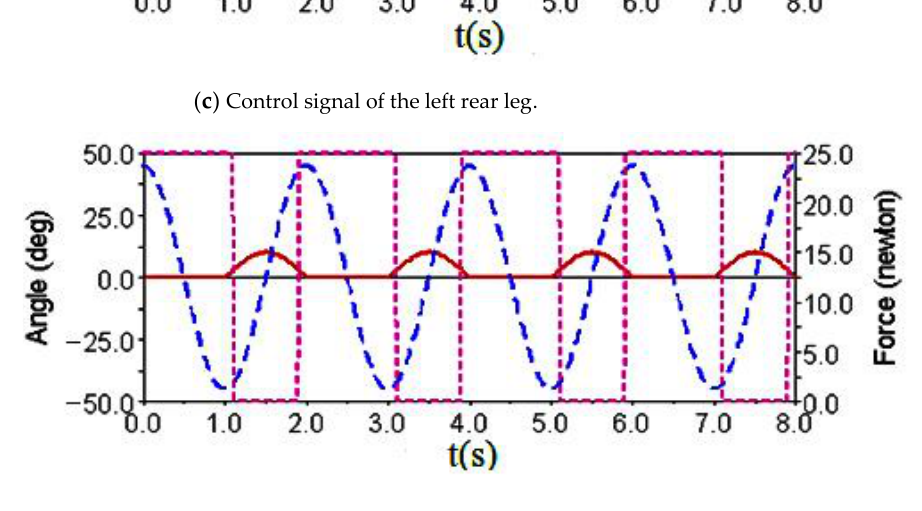
Figure 14. Centroid displacement curve of climbing step.